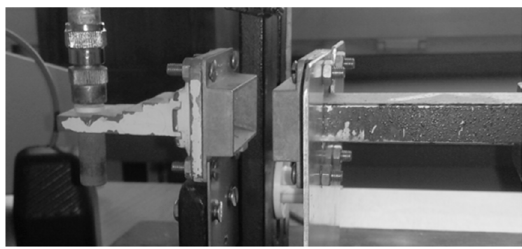
Figure 17. View of the shielding effectiveness measuring stand.